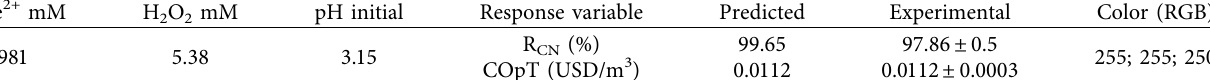
Table 5: Optimal operating conditions predicted for the Fenton process and its experimental